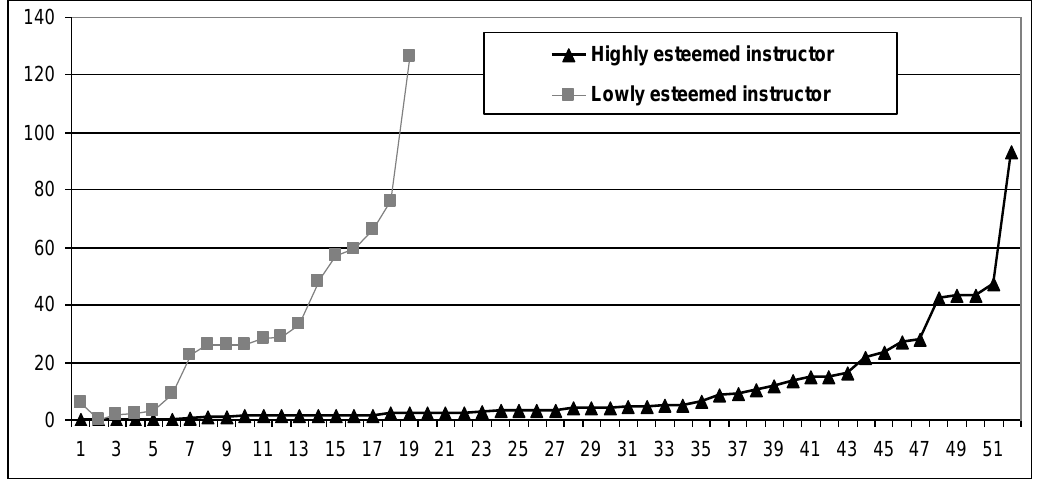
Figure 2 . Instructors‟ response times (in